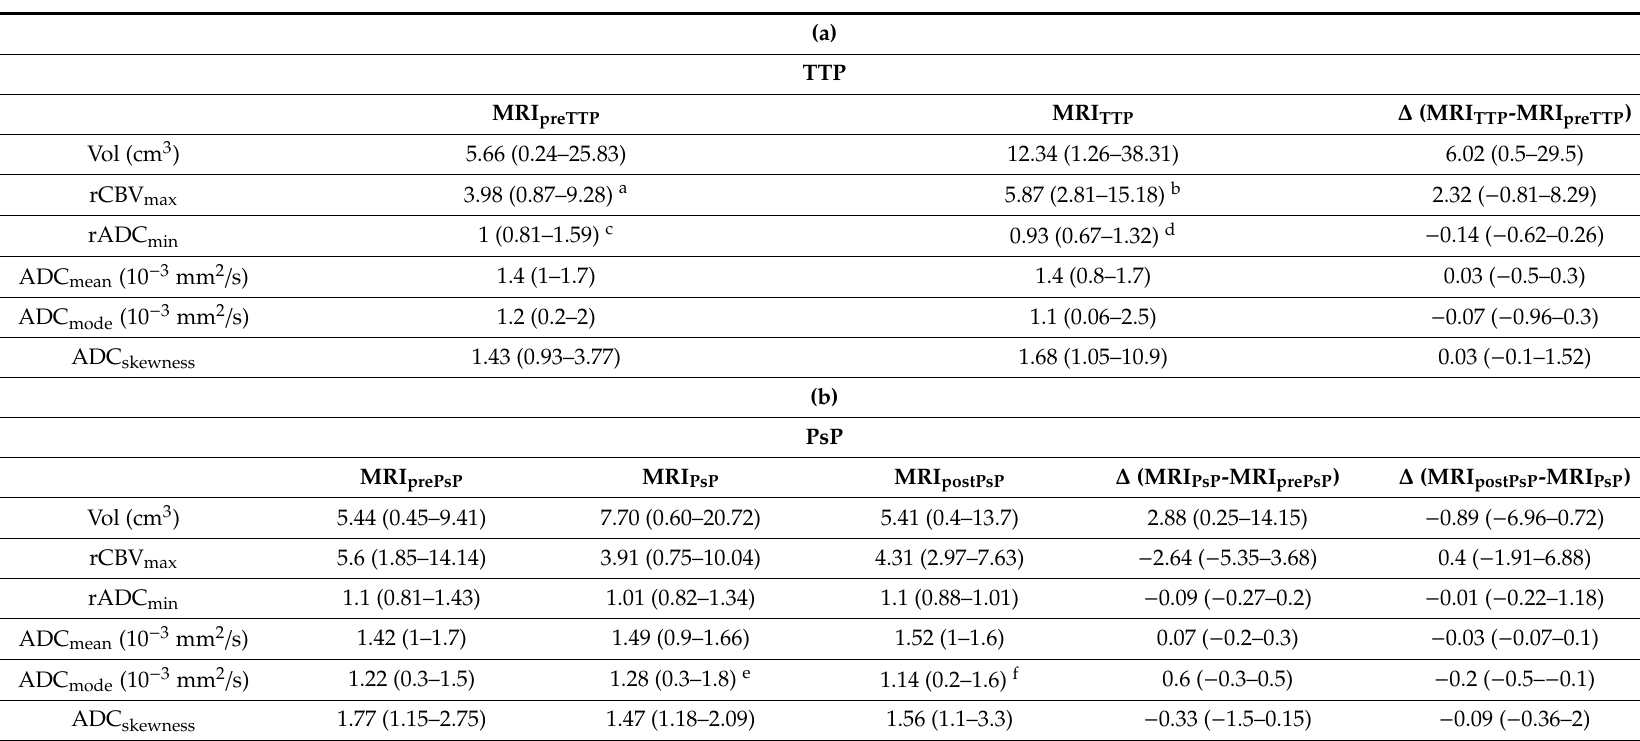
Table 2. ( a ) median values with range observed two months before and during TTP. ( b ) median values with range observed two months before, during and two months after